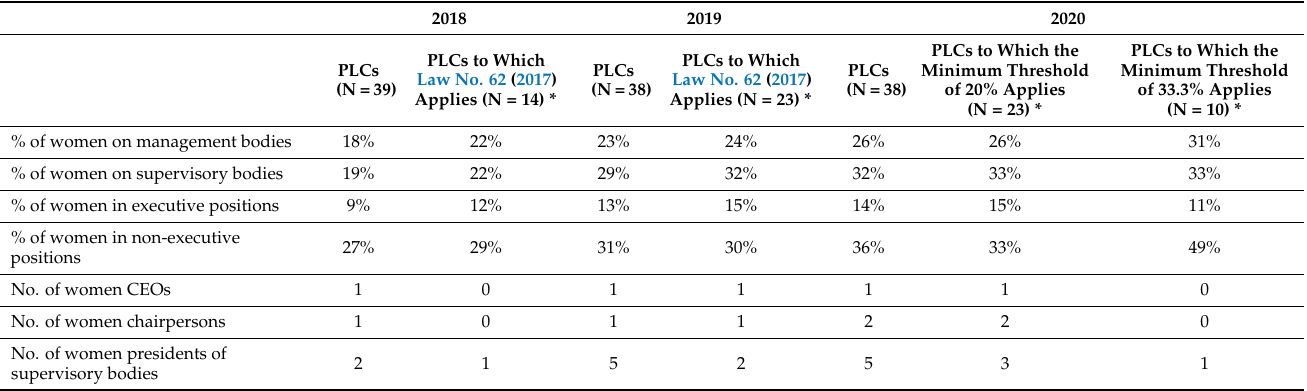
Table A1. Representation of women on the management and supervisory bodies of PLCs in Portugal